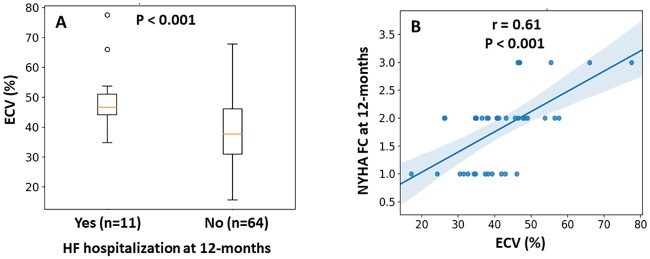
The relation between ECV fraction and clinical outcomes.(A) In a logistic regression model, extracellular volume (ECV) fraction in patients hospitalized for heart failure (HF) at 12-months was significantly higher than in those who were not. (B) Increased ECV fraction was associated with worse functional class at 12 months (r = 0.6, p<0.001). To note, there were no patients with NYHA FC 4 in our cohort. NYHA = New York Heart Association; FC = Functional class.